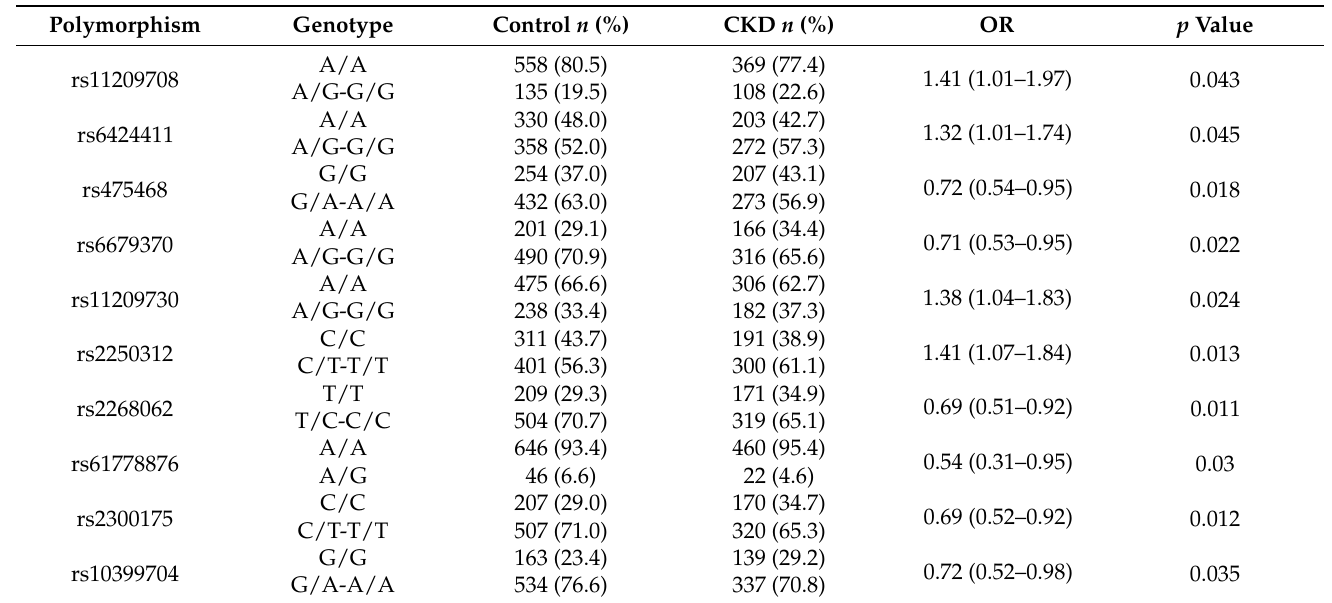
Table 2. Association of PTGER3 polymorphisms with the risk of nephrosclerosis. Odds ratios with 95% confidence intervals (OR) were adjusted by sex, age, ethnicity, diabetes and hypertension.